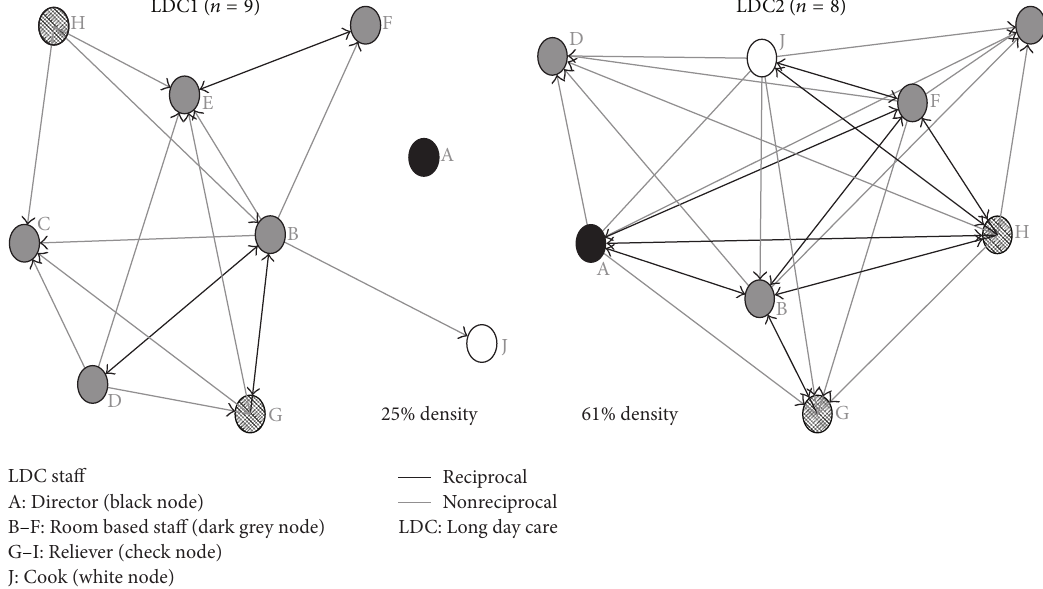
Figure 2: LDC1 and LDC2 physical activity planning information